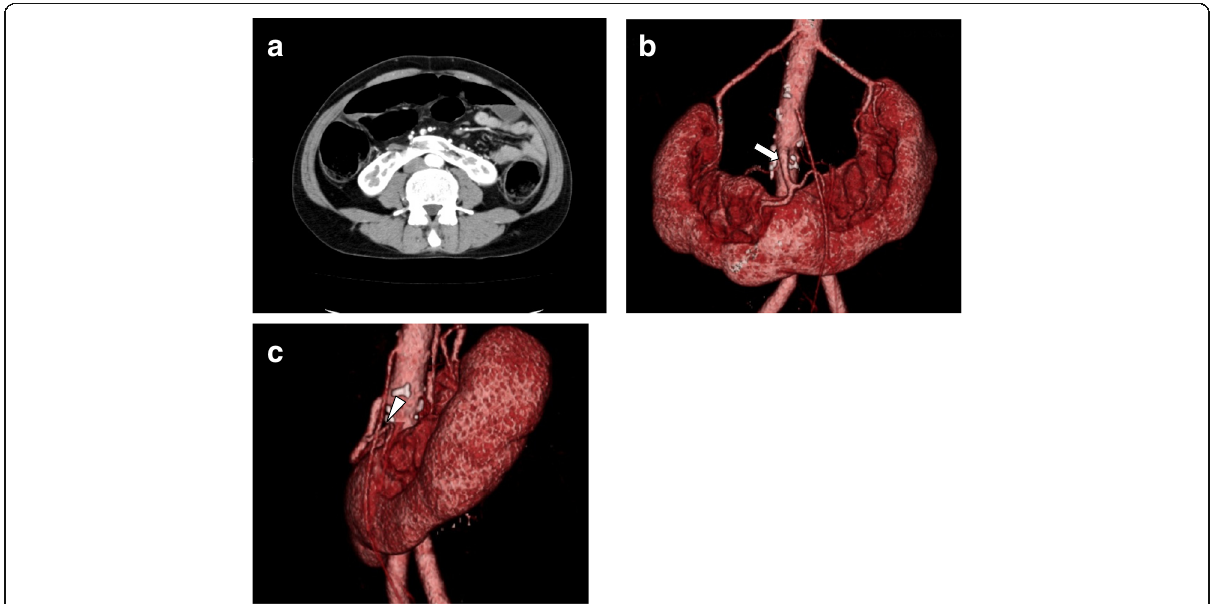
Fig. 1 a Abdominal CT showing horseshoe kidney. b , c 3D-CT angiography shows the root of an aberrant renal artery (white arrow) at the isthmus from 3 cm under the IMA branch of the aorta, and the left branch of aberrant renal artery (arrowhead) was close to